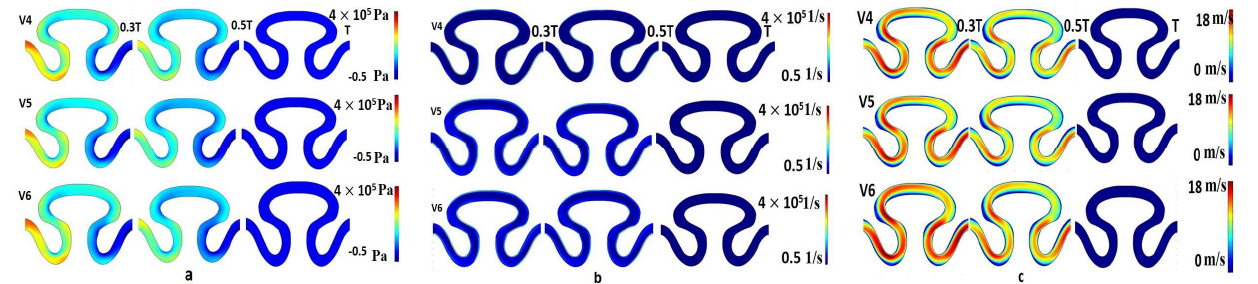
Figure 7. Contour Plot of ( a ) pressure, ( b ) shear rate, ( c ) axial velocity for sinusoidal flow, no-slip wall boundary condition for velocity models V 1 , V 2 , and V 3. The contour plot of pressure for velocity models V 4 , V 5 , and V 6 at a measured time period T/3, T/2, and T sec was evaluated similarly for physiological flow with no slip wall boundary condition (condition III). For each velocity model, it was observed that local maximum pressure (3.5–4 × 10 5 Pa) developed at the T/3 and T/2 sec at the neck region of the channel, as shown in Figure 8a. For the same condition, the local maximum (at neck region) and minimum (rear and abdominal regions) shear rate value were predicted as 4.5 × 10 5 1/s and 0.5 × 10 5 1/s, respectively (Figure 8b). The range of local minimum and maximum axial velocity was calculated between 0 to 18 mm/min, respectively (Figure 8c). The velocity contour was found to be higher for periods T/3 and T/2 sec. Maximum velocity had been developed at the neck region of the serpentine channel.